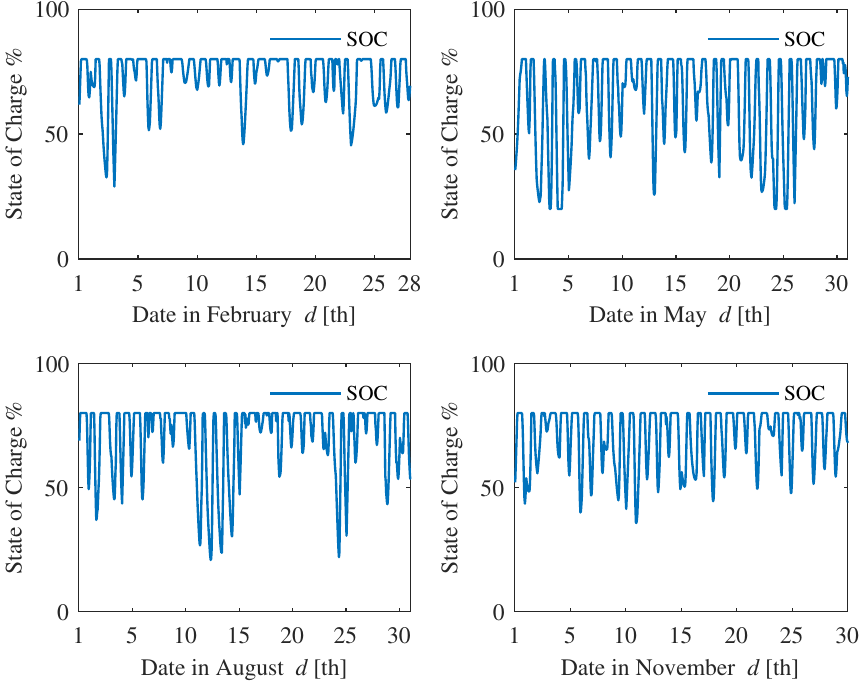
Figure 13. SOC of Case 3 for 4 months.